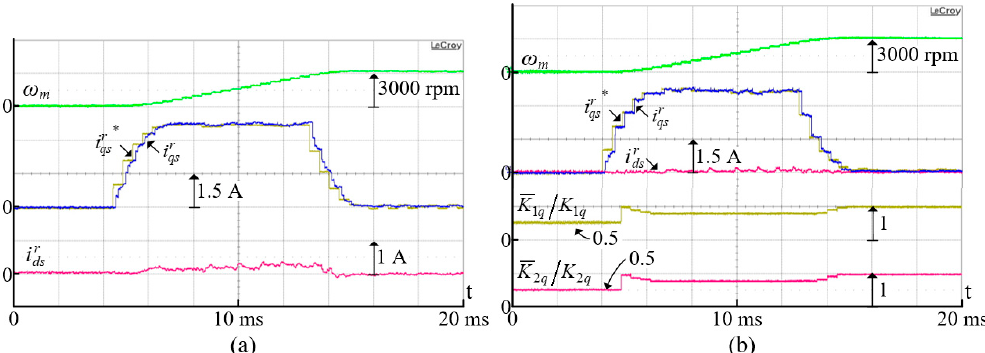
Figure 24. The amplified current response in the acceleration region of Figure 23 with ˆ L qs = 0.5 L qs when the online current loop tuning is ( a ) de-activated and ( b ) activated.